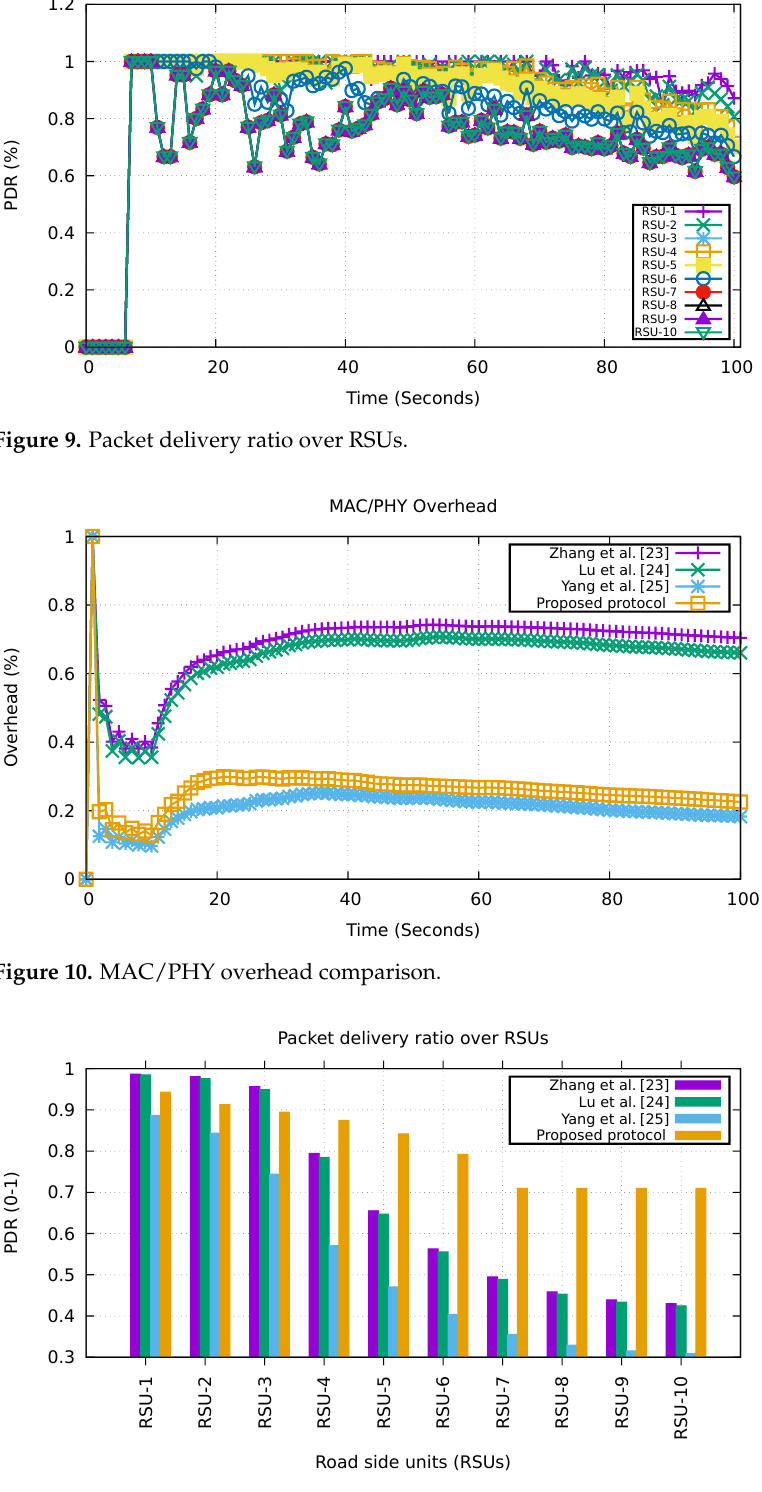
Figure 11. Packet delivery ratio over RSUs